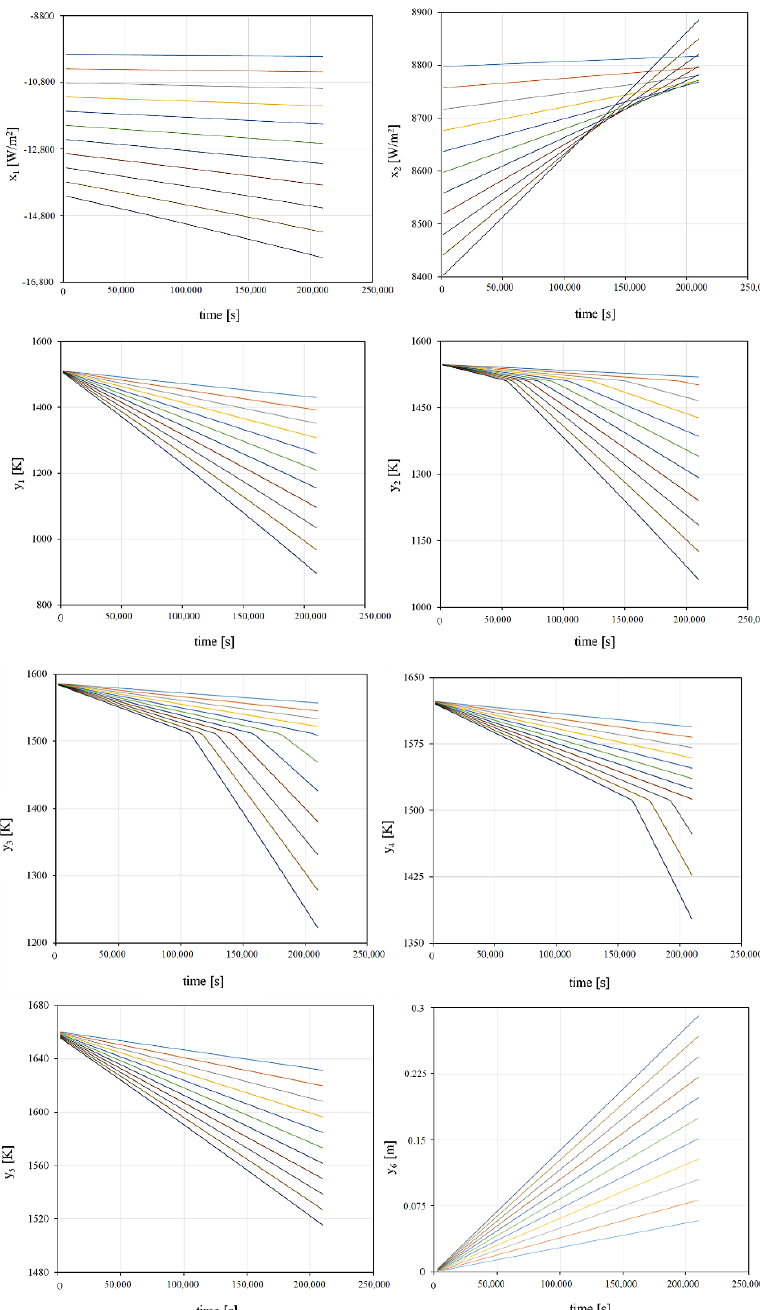
Figure 2. Examples of crystal growth datasets: temporal profiles of inputs x 1 , x 2 (incoming and outgoing heat fluxes), temporal profiles of outputs y 1 to y 5 (temperatures in characteristic points in GaAs) and y 6 (interface position in GaAs).